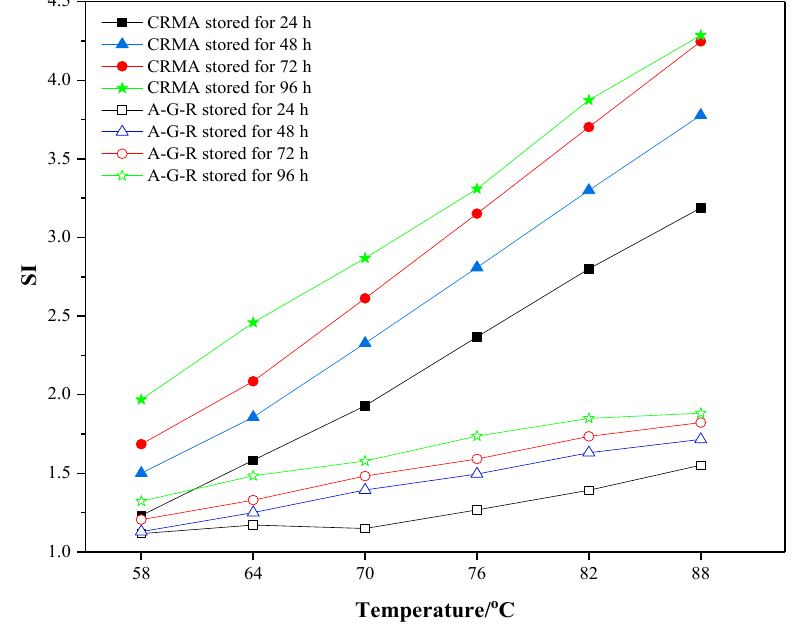
Figure 10. Segregation index curves of CRMA and A-G-R.